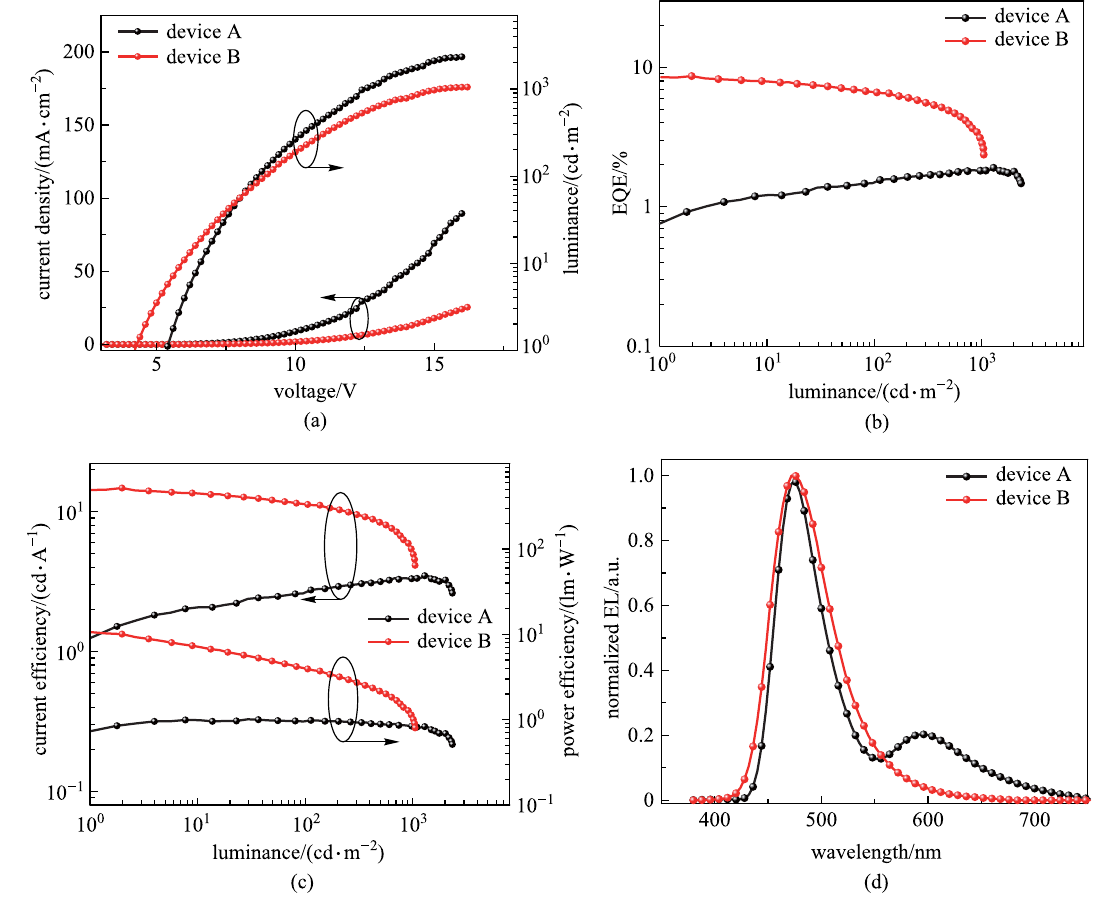
Fig. 6 a J-V-L curves; b EQE versus luminance curves; c CE- L -PE curves and d normalized EL spectrum at 6 V. (In devices A and B, the EMLs of SPy and DPEPO: DMAC-DPS: SPy are used,